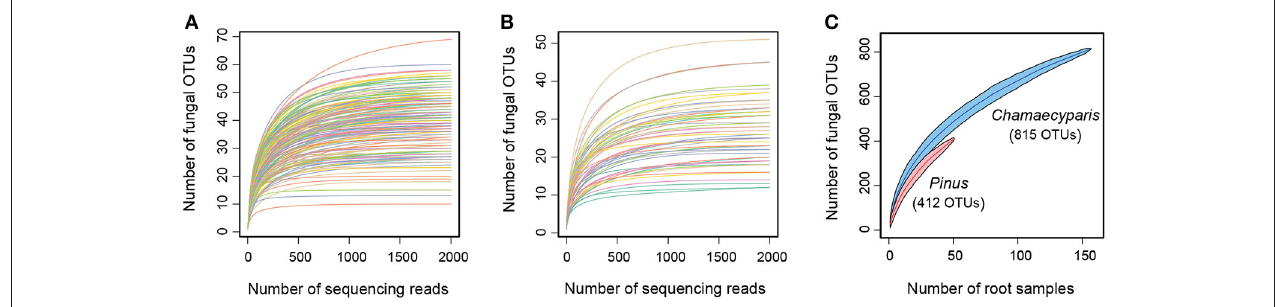
FIGURE 1 | Fungal OTU richness. (A) Relationship between the number of sequencing reads and that of fungal OTUs ( Chamaecyparis root samples). (B) Relationship between the number of sequencing reads and that of fungal OTUs ( Pinus root samples). (C) Relationship between the number of root samples and that of fungal OTUs.